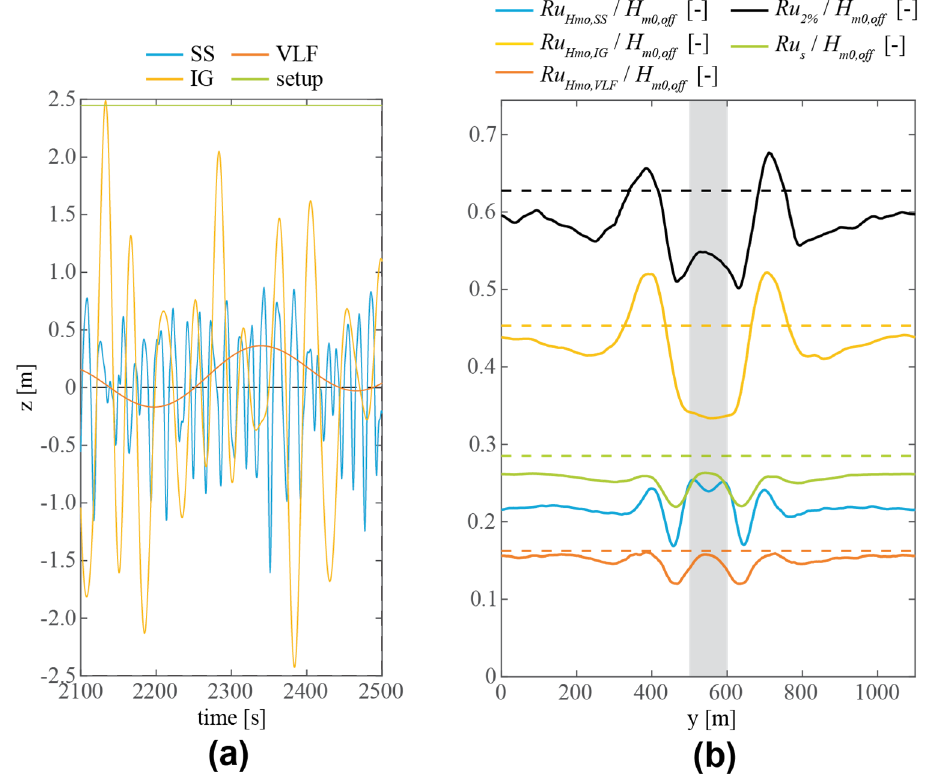
Figure 5. Frequency components of waves and runup on the reef flat. ( a ) Time series of the SS (blue), IG (orange), VLF (red), and setup (green) components of water level, taken in the middle of reef by the shoreline. ( b ) Alongshore varying runup ( Ru 2% , black) split into setup ( Ru s , green), SS ( Ru Hmo,SS , blue), IG ( Ru Hmo,IG , orange), and VLF ( Ru Hmo,VLF , red) wave components, presented as the fraction of the incoming waves by normalizing with wave height at the offshore boundary ( Ho ). The dashed lines in corresponding colors show the frequency components in the reference run without a channel. The gray region denotes the location of the channel.